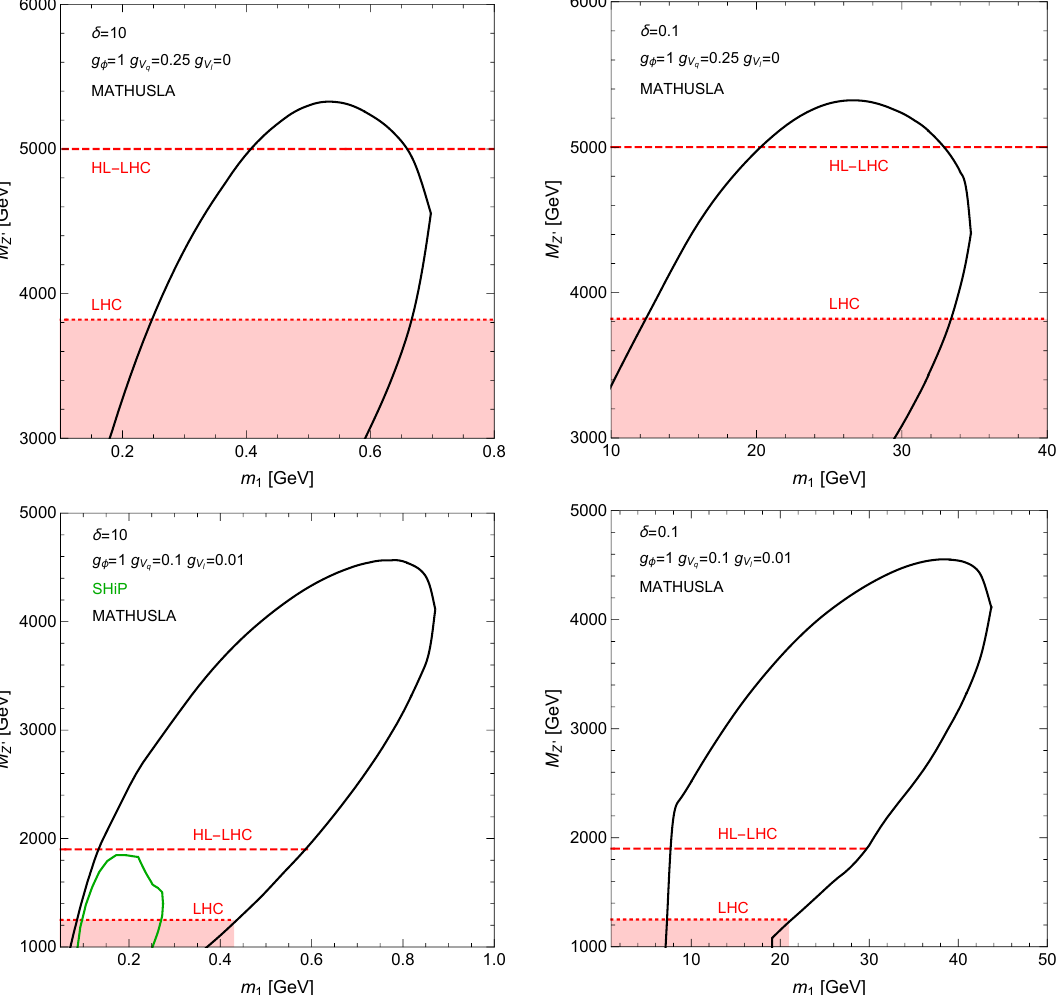
Figure 5 . 90% CL projected sensitivities to the Z 0 model in eq. (1.4). Top and bottom panels are for two choices of the couplings of the Z 0 to the SM fermions. Left and right panels are for a mass splitting between dark states of δ = 10 and δ = 0 . 1 respectively. The red regions below the red dotted line are excluded by the current LHC constraints discussed in section 4.1. The dashed red lines show the expected future sensitivity of the